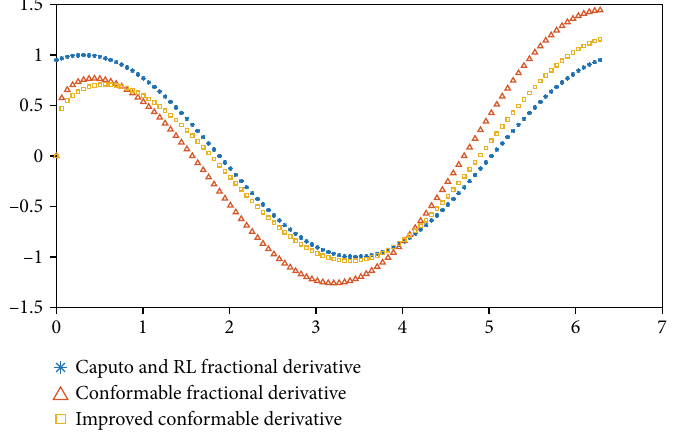
Figure 8: 0.8th fractional derivative of y = sin x .